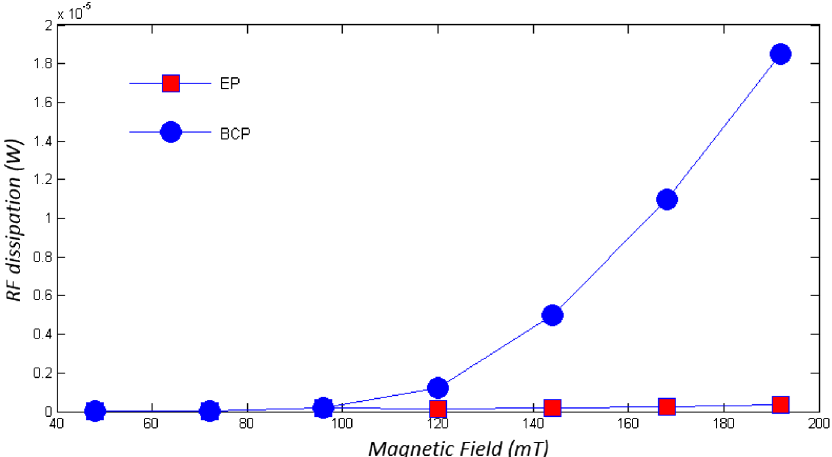
FIG. 15. Average topography-induced power dissipation on 100 μ m × 100 μ m BCP and EP surfaces plotted as a function of peak applied H fi eld. Superconducting state losses are